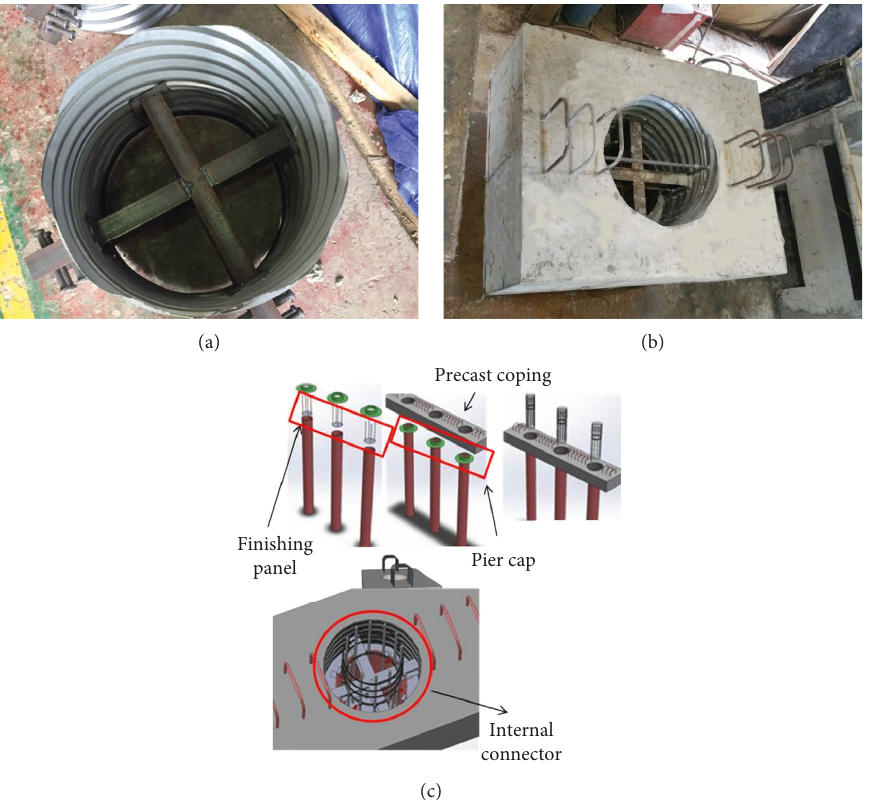
Figure 1: Precast concrete bent cap with internal connector. (a) Internal connector, (b) precast concrete bent cap, and (c) construction